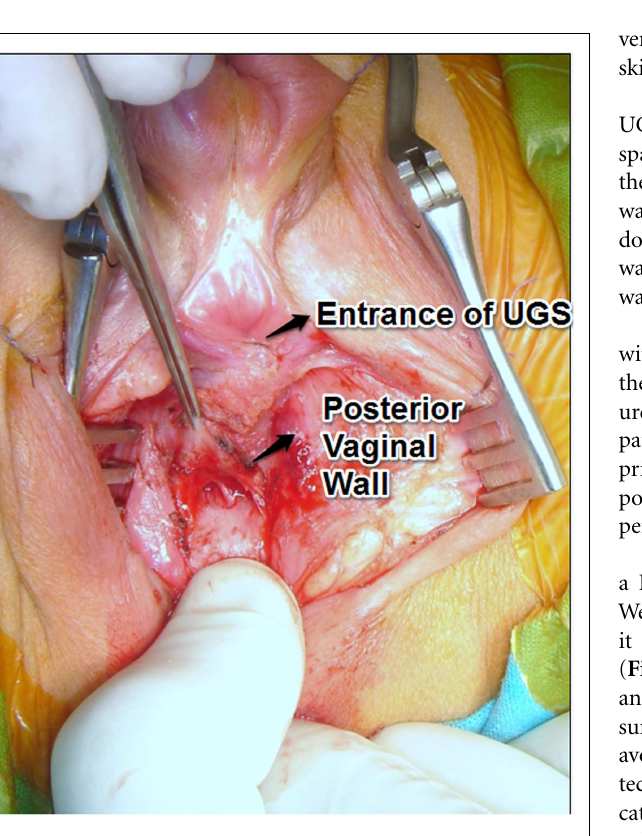
FIGURE 2 | Dissection of the posterior vaginal wall, separating it from the rectal wall before sectioning the UGS . A rectal finger is very useful to facilitate vaginal